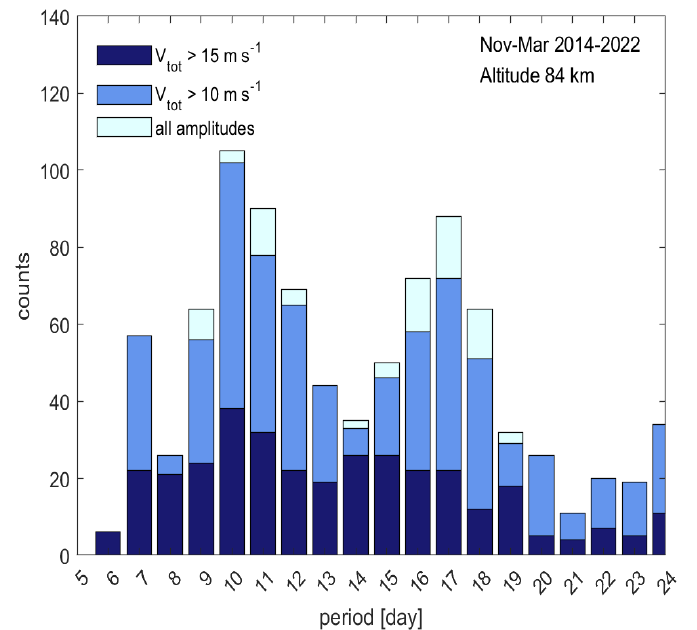
Figure 5. Distribution of Q16DW periods in the boreal winter (Nov–March) for the years 2014–2022. Dark blue: amplitudes larger than 15 m s − 1 only. Light blue: amplitudes between 10 and 15 m s − 1 . Light cyan: amplitudes smaller than 10 m s − 1 .